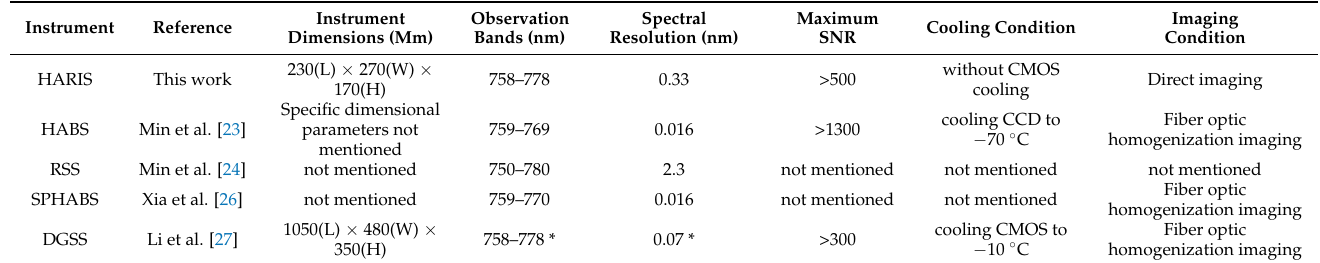
Table 1. Performance comparison of oxygen A-band